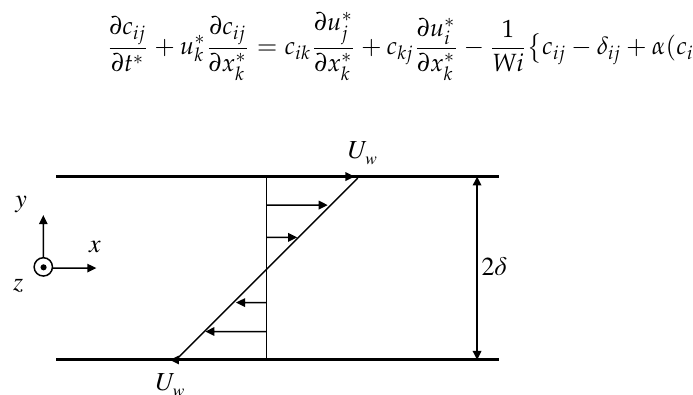
Figure 1. Configuration of the plane Couette